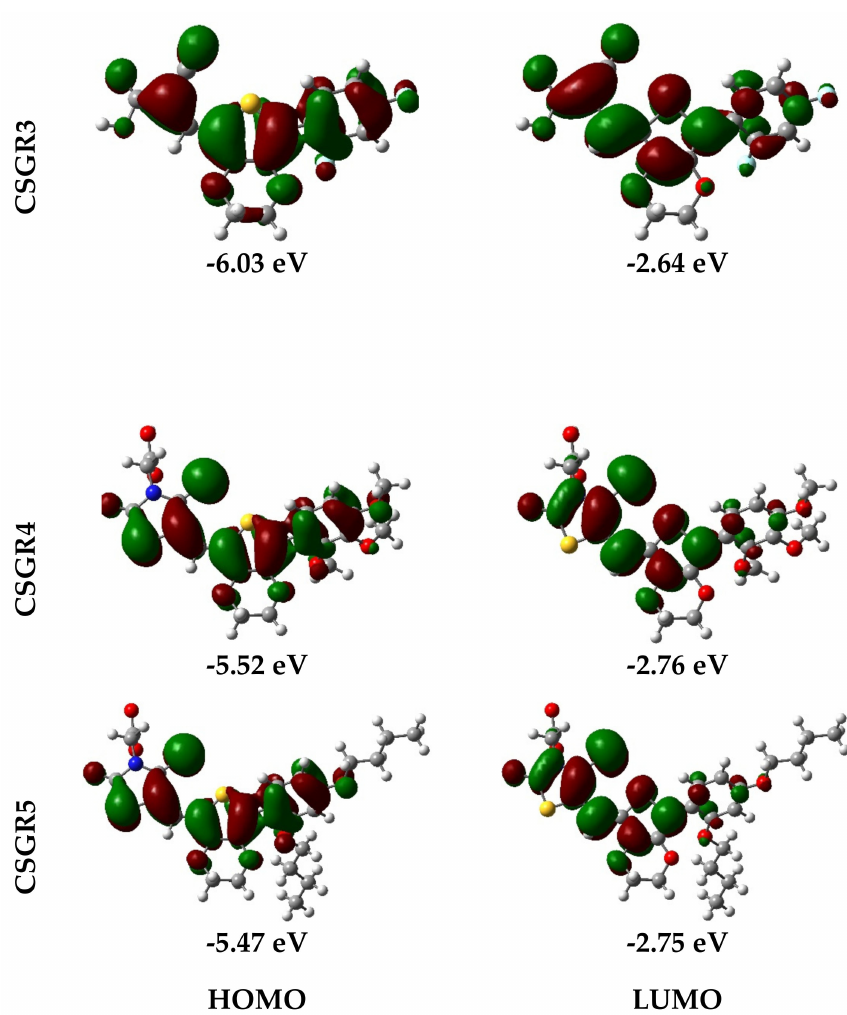
Figure 9. Electron density distribution in frontier molecular orbitals of the dyes CSGR1 to CSGR5 and the corresponding